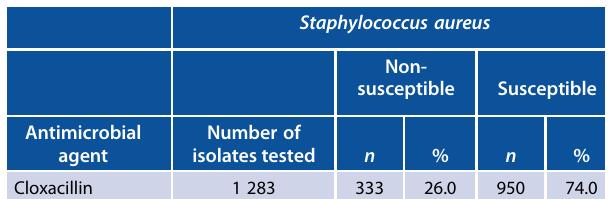
Table 4: Antimicrobial susceptibility patterns of Staphylococcus aureus isolated from blood cultures reported from four private groups in